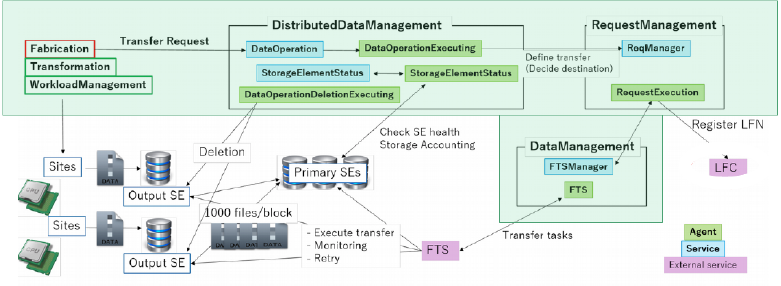
Figure 7. Distributed data management DIRAC components and their connections to the FTS, storage elements, and LFC.